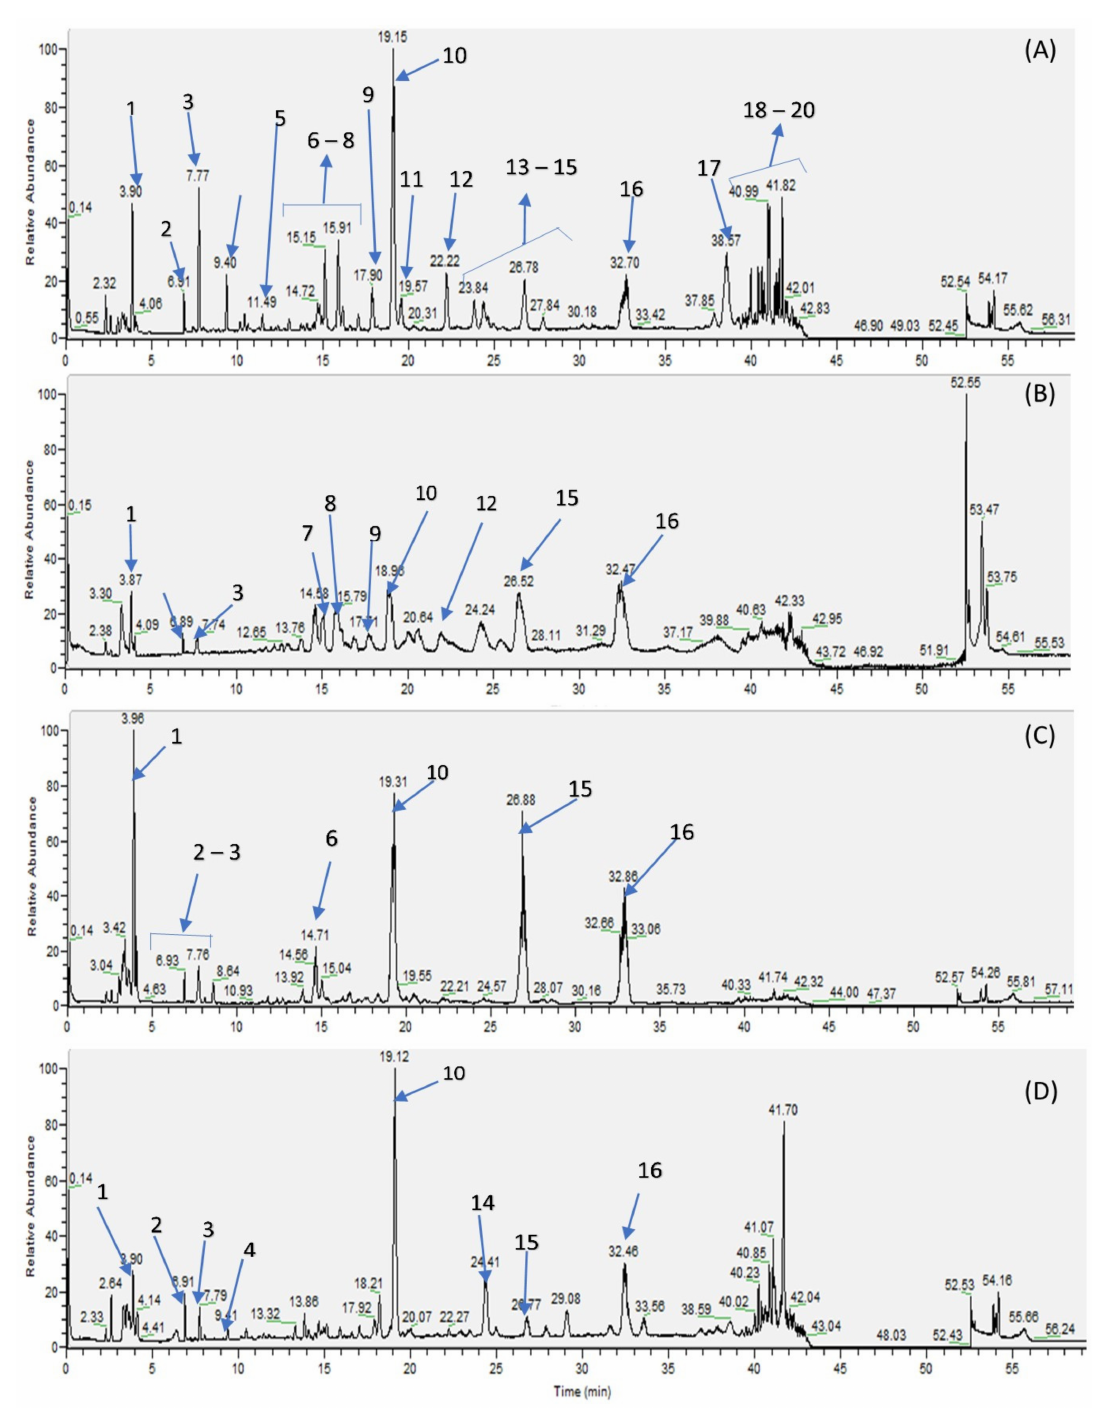
Figure 1. LC-MS chromatograms in negative mode of methanolic extracts of V. madiensis ( A ) leaves; ( B ) trunk bark; ( C ) root bark; ( D )